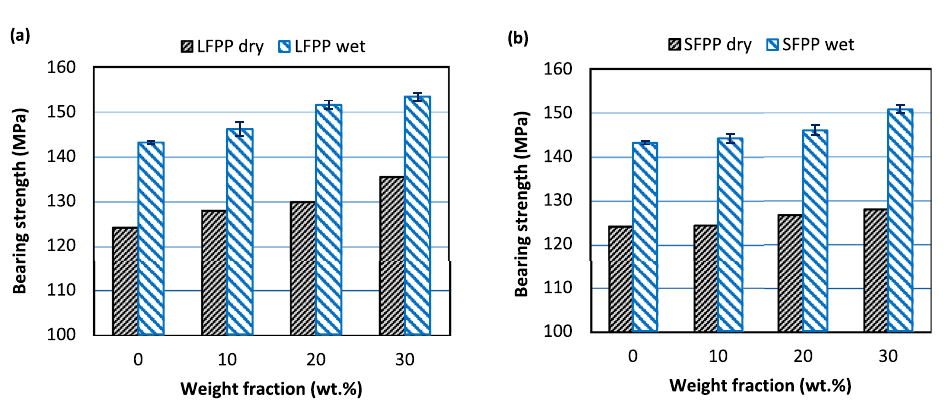
Figure 7. Bearing strengths in both dry and wet conditions for; ( a ) LFPP and ( b )